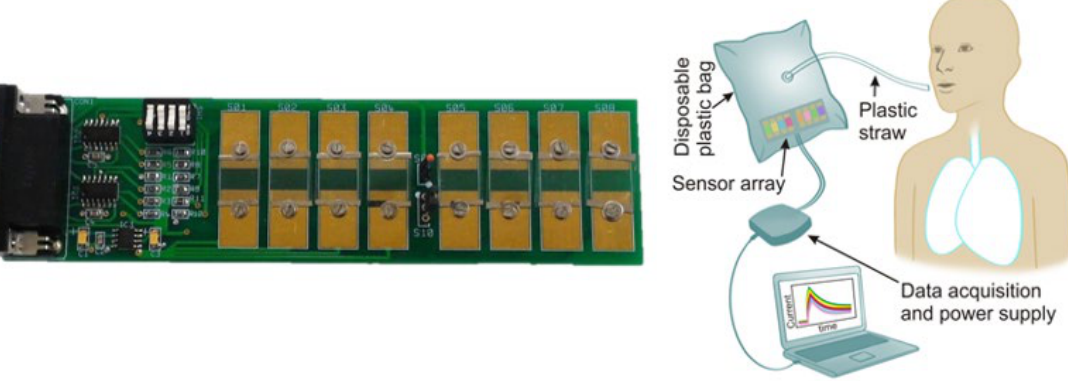
Figure 10. ( Left side ), picture of the eight-sensor array reported by [52,53]; reproduced with permission from [52]. ( Right side ), schematic representation of the breath sampling collection method reported by [52,53]: a disposable polytetrafluoroethylene (PTFE) bag contains the sensor array. After inserting the sensing unit, the bag was zipped on the side where the cable connected the unit to the data logger. Subjects inhaled to maximal inspiration and inflated the PTFE bag through a plastic straw. After the bag was inflated, the straw was extracted, and the bag was properly sealed to preserve the integrity of the sample. The sensor array inside the bag was exposed to exhaled breath for about 180 s to let all sensors fully interact with the target molecules. Then, the bags were opened, and the sensor array was cleaned with dry air before the next measurement to allow the sensors to recover. Reproduced from Ref. [53] with permission from the Royal Society of Chemistry.